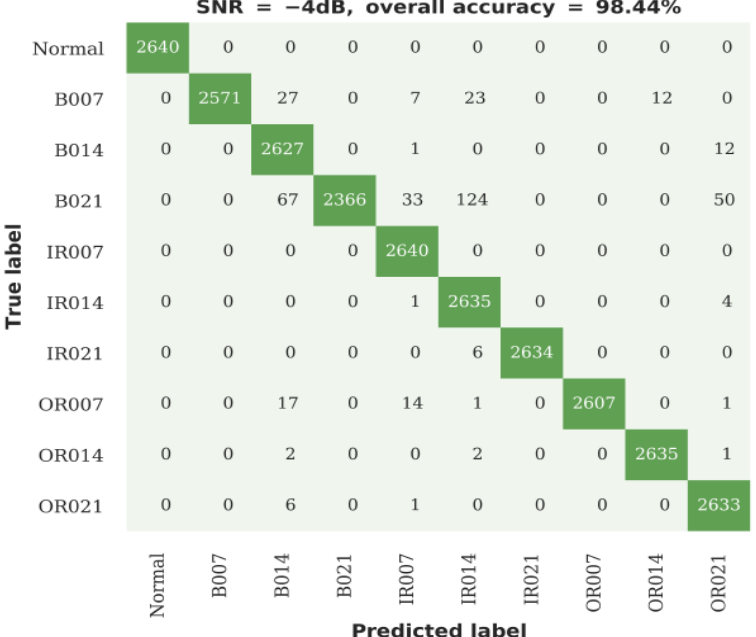
Figure 34. Confusion matrix plot for proposed algorithm RNN-WDCNN to diagnose ball bearing, inner raceway, and outer raceway bearing faults [95].